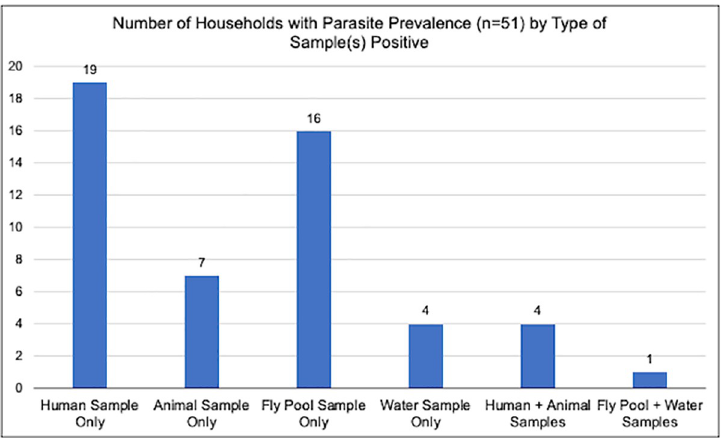
Fig 2. Sample types positive for Cryptosporidium spp . and/or Giardia duodenalis at each Mongolian household with zoonotic enteric parasite presence.